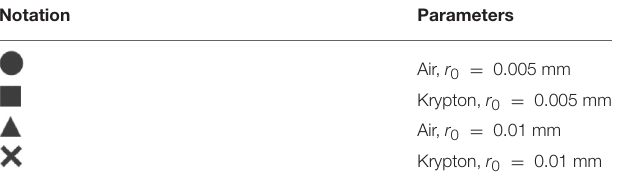
TABLE 3 | The notations used in the figures.